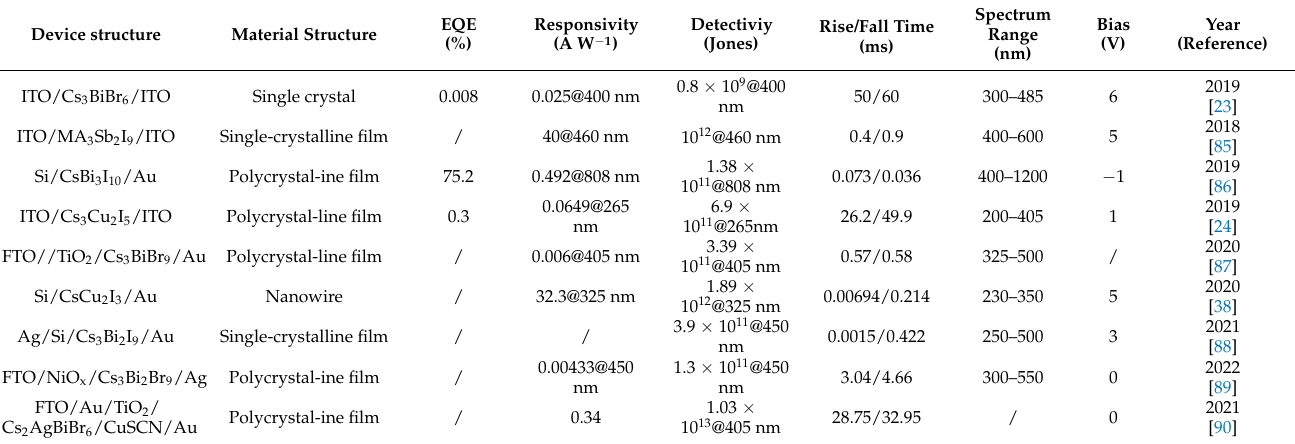
Table 3. Comparison of optical detection performance of lead-free perovskite photodetectors reported in the previous